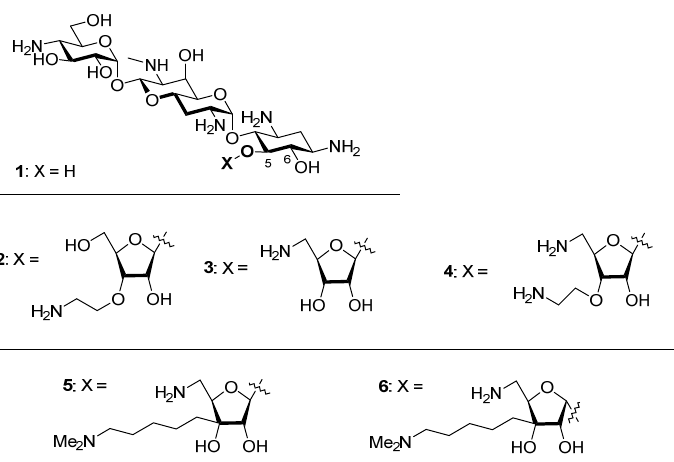
Figure 1. Apramycin 1 , Apralogs 2–4 , and the Target Compounds 5 and 6 .